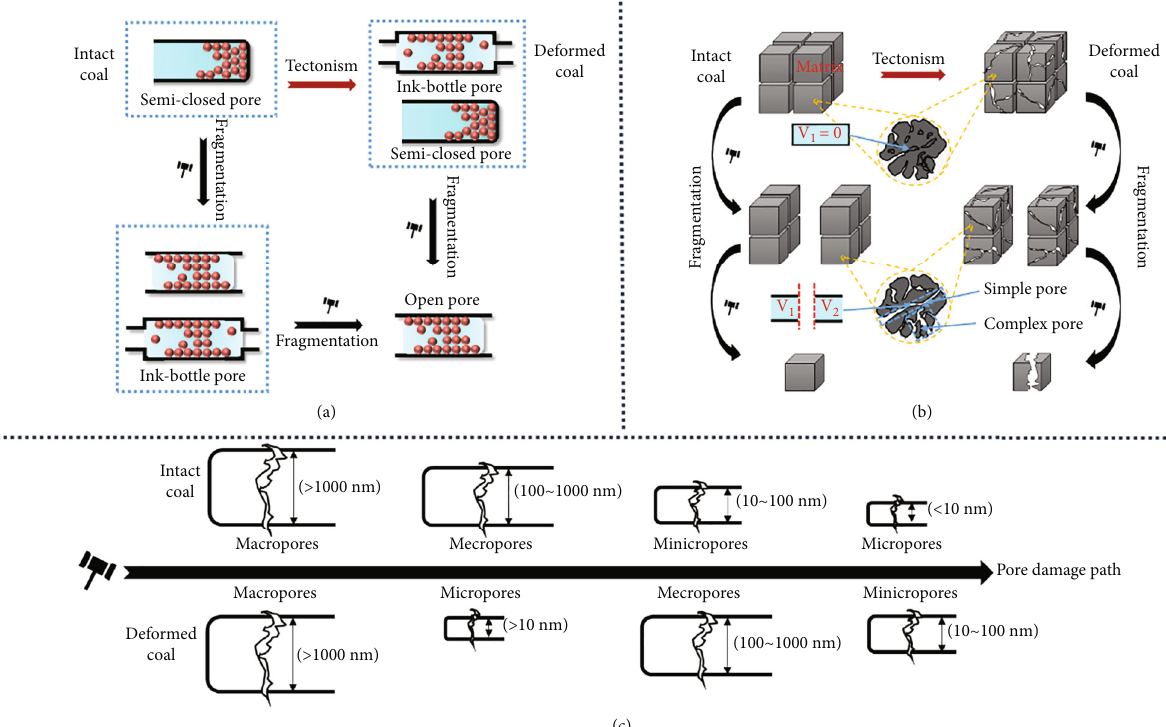
Figure 11: Pulverization evolution processes of intact coal and deformed coal: (a) evolution of pore shapes, (b) evolution process of pore damage, and (c) damage